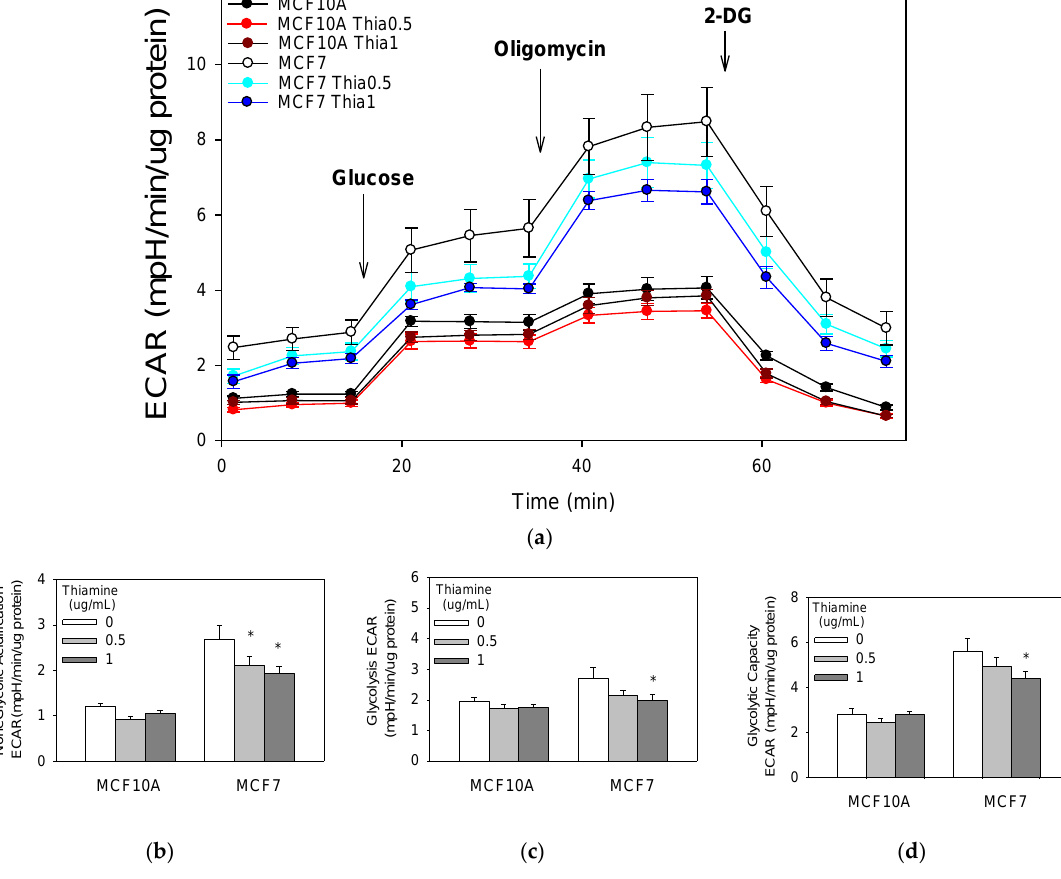
Figure 4. Glycolysis stress test (a) . Cells were treated with a range of doses of thiamine for 24 h before a glycolysis stress test (Seahorse Bioscience, Billerica, MA, USA). Thiamine decreases non-glycolytic acidification ( b ), glycolysis ( c ), and glycolytic capacity ( d ) in breast cancer cells. Results are expressed as mean ± SE (* significant difference relative to control (0 μg/mL Thiamine supplementation), white bar).